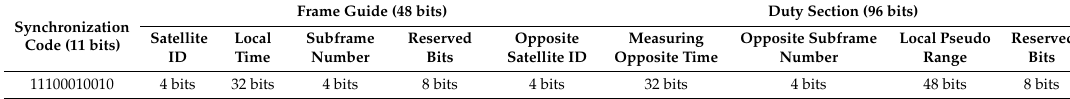
Table 1. Detail structure of inter-satellite transmission subframe.